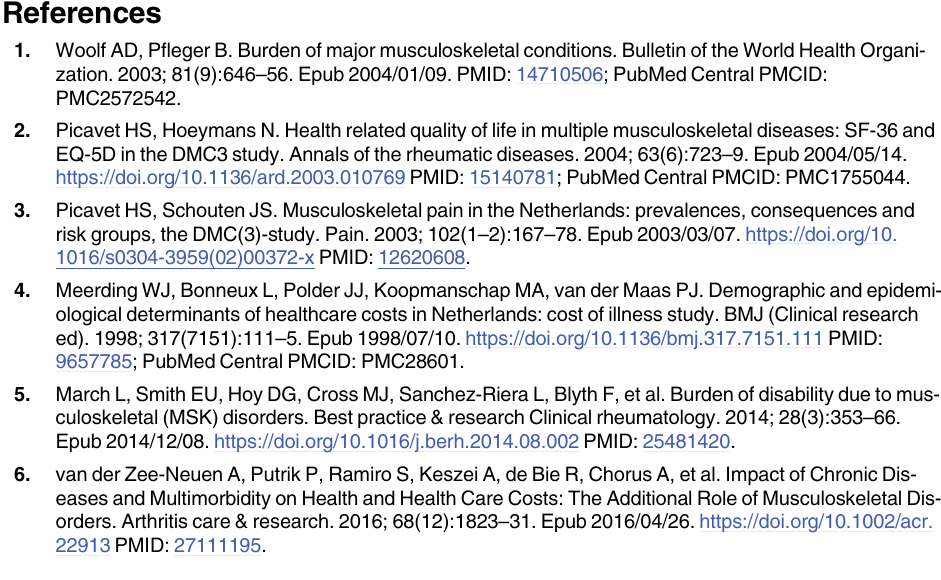
S1 Table. Sensitivity analysis predictive validity using different subgroup